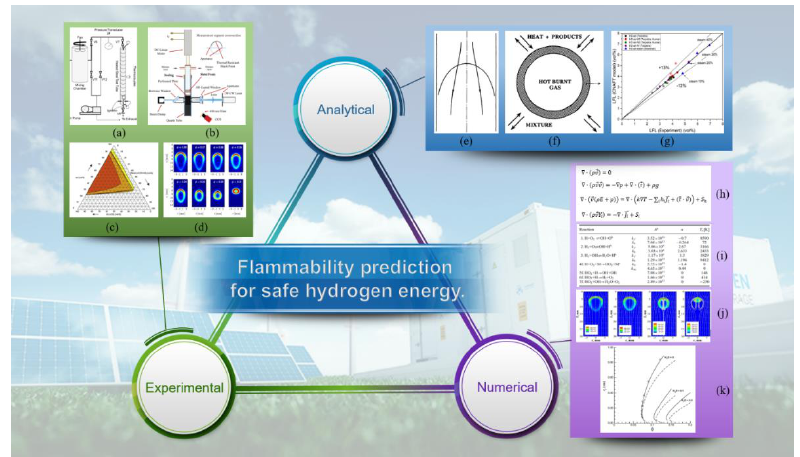
Figure 2. Analytical, numerical and experimental studies for prediction of hydrogen flammability (( a ) standard tube for measuring the flammability limit [15], ( b ) schematic of experimental setup for stabilized flame observation [16], ( c ) Shapiro diagram for flammability [17], ( d ) chemiluminescence images of flame [18], ( e ) configuration of straining flow [19], ( f ) configuration of flame ball concept [20], ( g ) accuracy of the calculated non-adiabatic flame temperature (CNAFT) model [11], ( h ) governing equations for numerical flame analysis, ( i ) reduced chemical kinetics [21], ( j ) flame structures by numerical simulation [22], ( k ) identified turning point in flame ball analysis [23]).